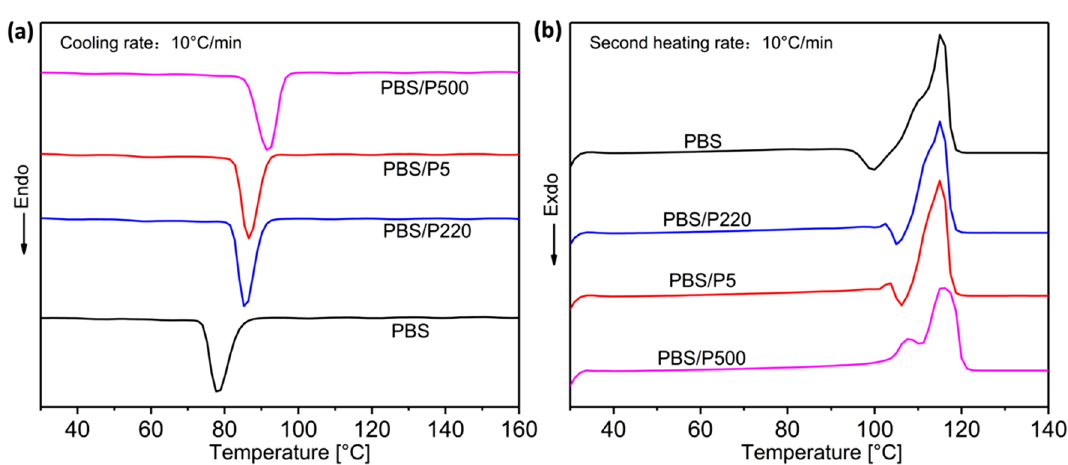
Figure 6. DSC curves of PBS and PBS/PTFE composites: ( a ) cooling and ( b ) second heating.